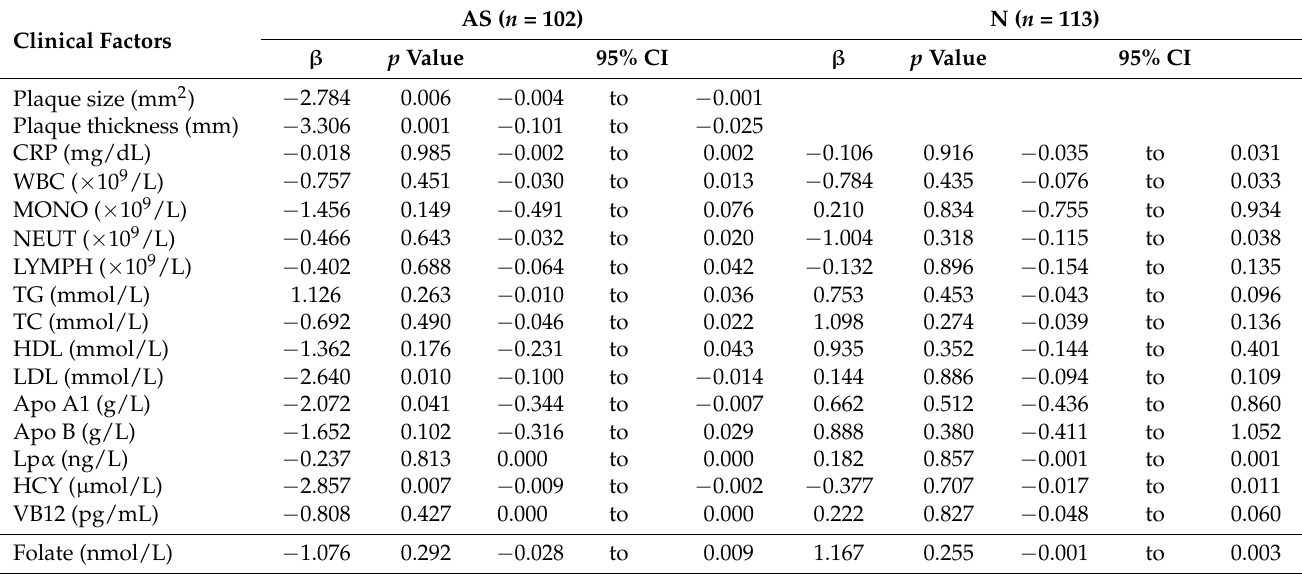
Table 1. Linear regression analysis of the association between cfDI and clinical factors adjusted by age and